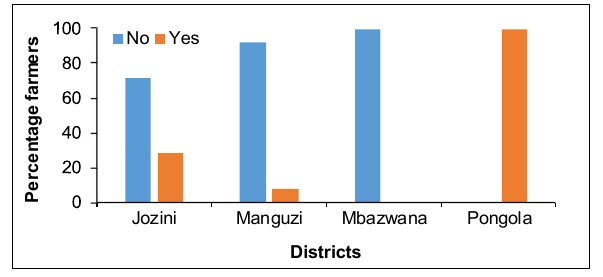
Figure 3: Rotation of groundnuts with other crops by subsistence farmers in four districts of northern KwaZulu-Natal (chi-square: d.f.=4; p =0.0122).